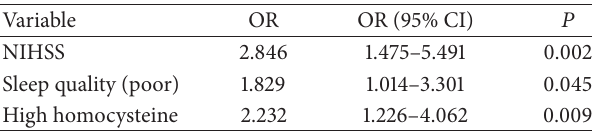
Table 4: Logistic regression analysis of prognostic factors in youth IS patients. By multivariate logistic regression analysis, association with the three-month MRS scores, from highest to lowest, were NIHSS score, high homocysteine and poor sleep